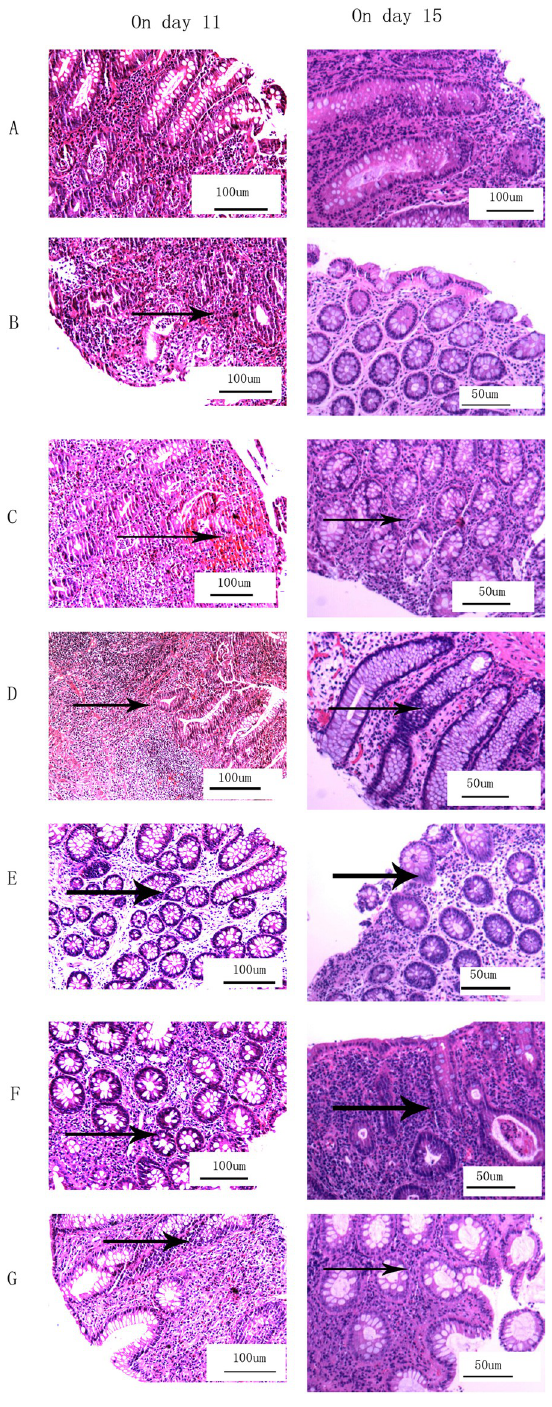
Fig 8. Pathological images of colonic hematoxylin-eosin staining. Images from groups (A) A, (B) B, (C) C, (D) D, (E) E, (F) F and (G) G. Left, rat colon tissue on day 11; right, rat colon tissue on day 15. In group A, no obvious neutrophil infiltration and mucosal edema were observed. In groups B-G, neutrophil infiltration was severe, and marked mucosal edema was notable; additionally, mucosal necrosis was observed, and focal ulcers were formed.